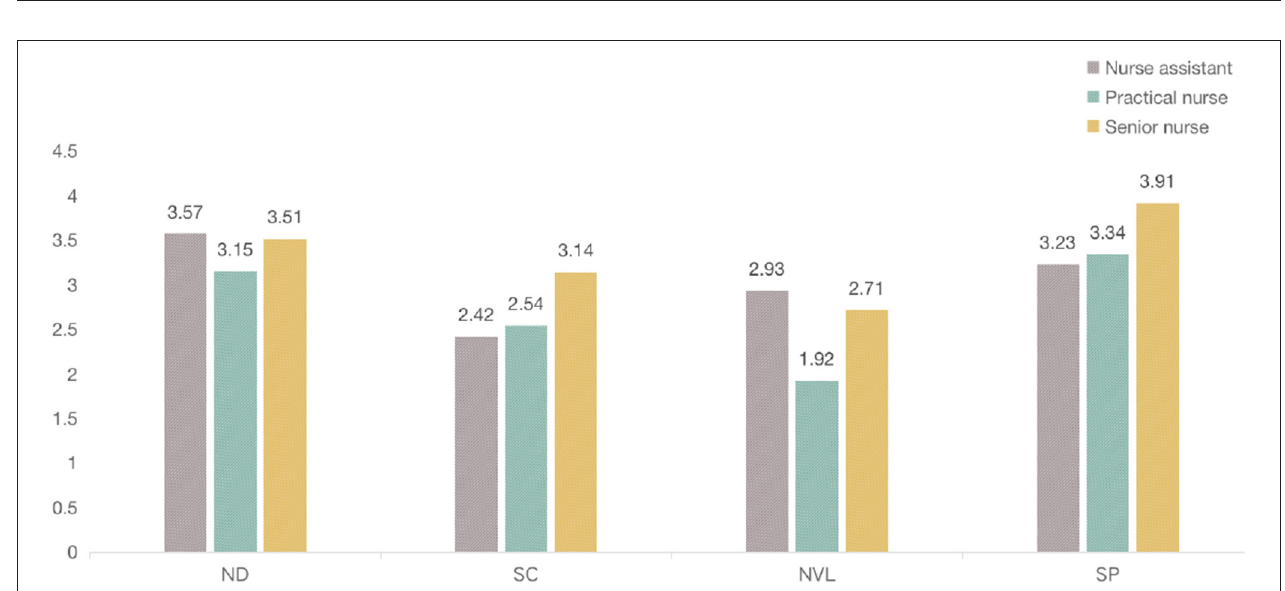
FIGURE 7 | Importance of environmental factors on the psychological fatigue.